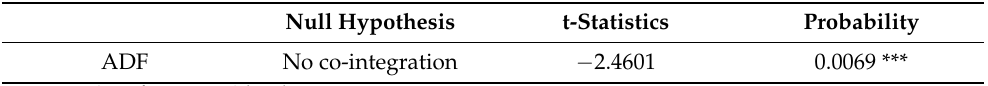
Table 7. Kao panel cointegration test